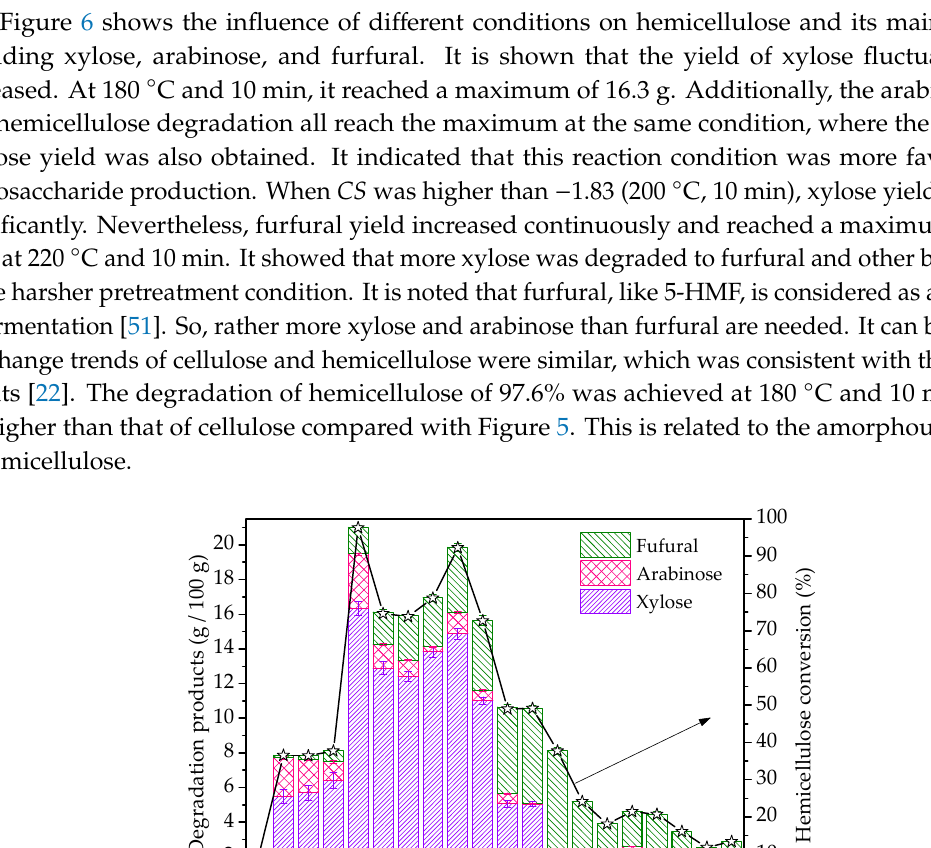
Figure 5. Effect of 1 × 10 − 5 mol / L FeCl 2 pretreatment on cellulose degradation. Figure 5. E ff ect of 1 × 10 − 5 mol / L FeCl 2 pretreatment on cellulose degradation.